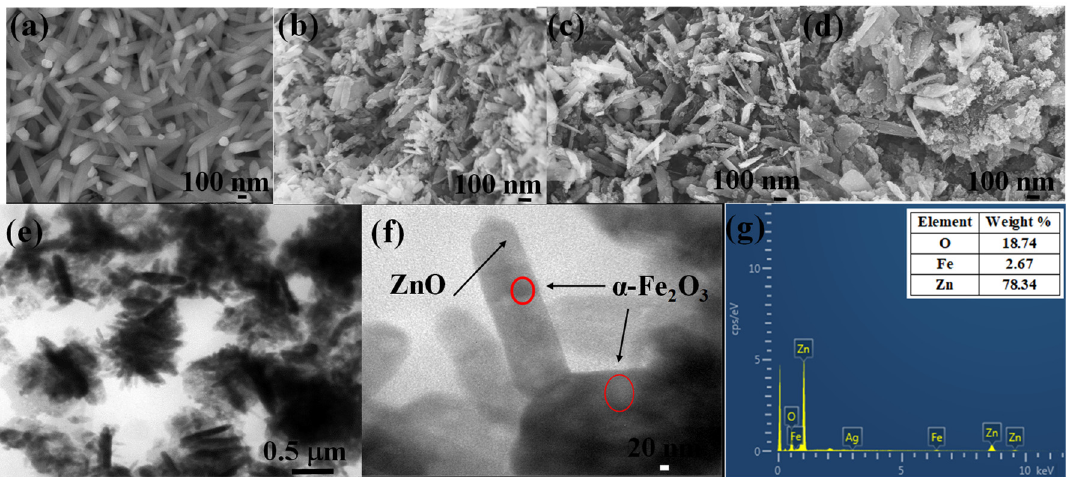
Figure 3. FE-SEM of ( a ) ZnO; ( b ) ZnO / α -Fe 2 O 3 (1 wt%); ( c ) ZnO / α -Fe 2 O 3 (3 wt%); ( d ) ZnO / α -Fe 2 O 3 (5 wt%); ( e ) and ( f ) TEM of ZnO / α -Fe 2 O 3 (3 wt%) with low and high magnification. ( g ) Energy dispersive X-ray Analysis (EDX) of ZnO / α -Fe 2 O 3 (5 wt%).